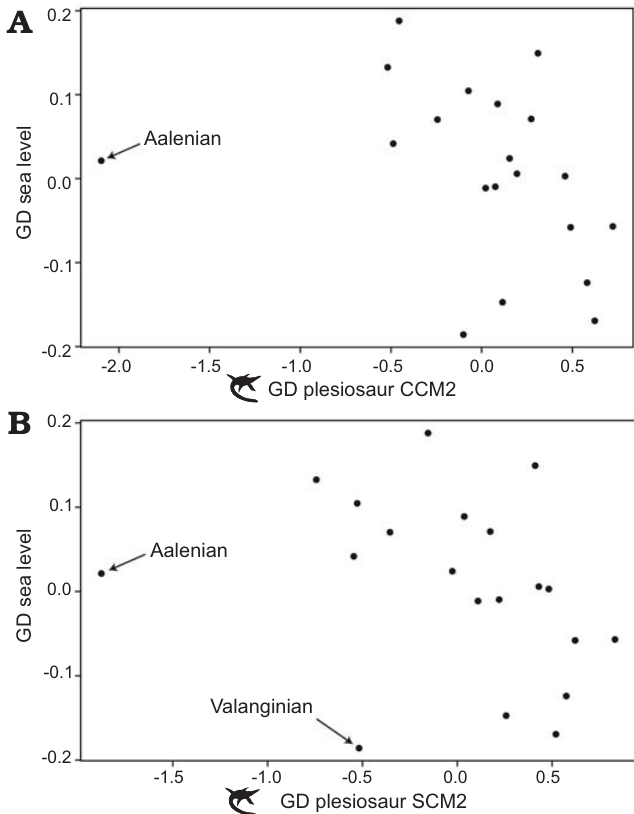
Fig. 7. Scatterplots comparing generalised differenced (GD) plesiosaur completeness data to GD sea level data. A . GD CCM2 versus GD sea level. Note the apparent existence of a correlation that is obscured by one outlier (Aalenian). B . GD SCM2 versus GD sea level. Note the